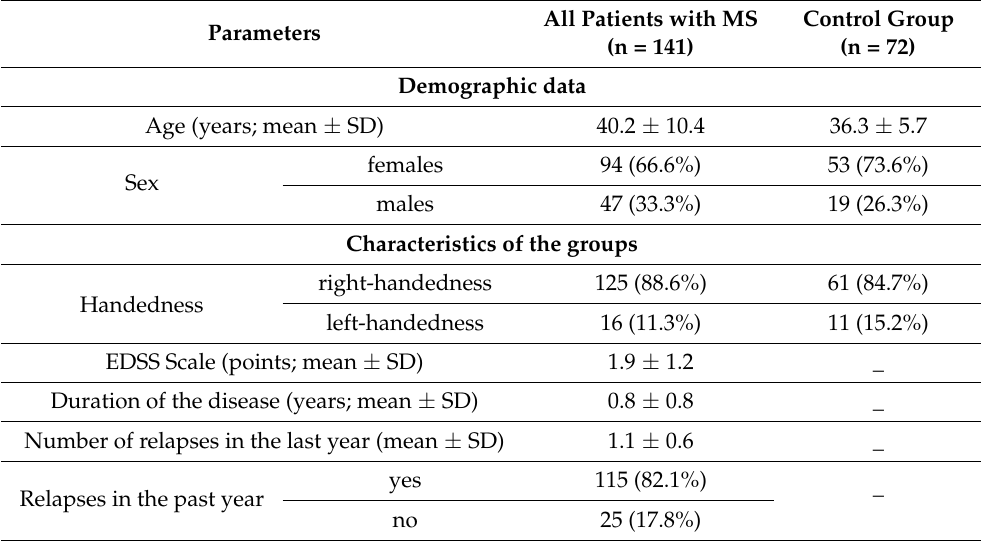
Table 1. Characteristics of the patients with MS in the study group and healthy participants in the control